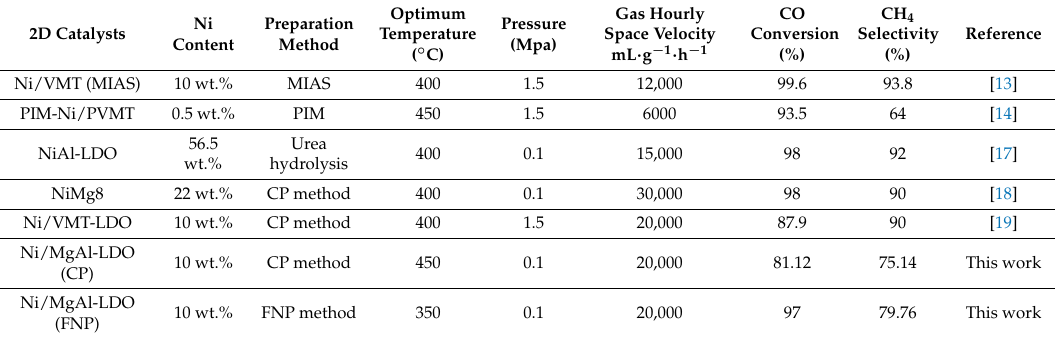
Table 1. Comparison of two-dimensional (2D) catalysts prepared via different methods. 2D Catalysts